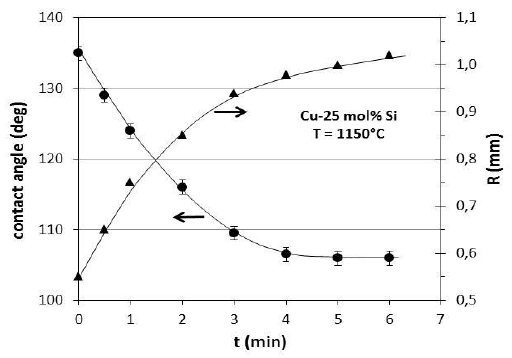
Figure 5. Contact angle and drop base radius as a function of time for a Cu-Si alloy on silica under high vacuum. Dispensed drop technique. Results from